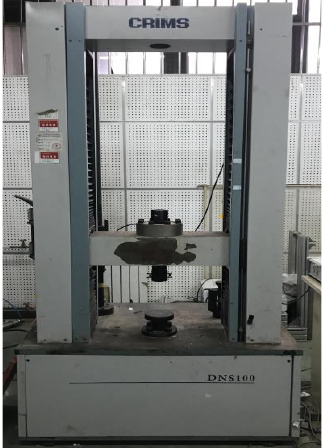
Figure 2. DNS100 electromechanical testing machine.